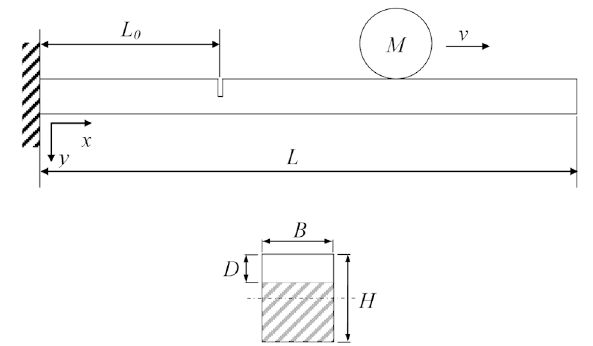
Fig. 1. Cracked cantilever beam under moving mass